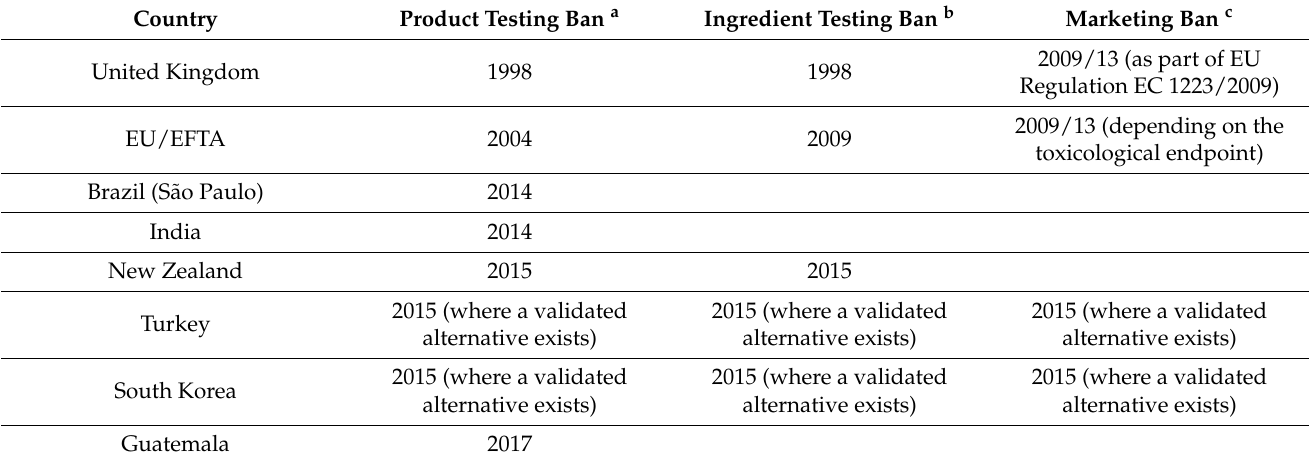
Table 2. Cosmetic animal testing bans [17,54,55]; (a) ban relating to the testing of cosmetic products within the country’s borders; (b) ban relating to the testing of cosmetic ingredients within the country’s borders; (c) ban relating to the marketing of products tested on animals, within the country’s borders or